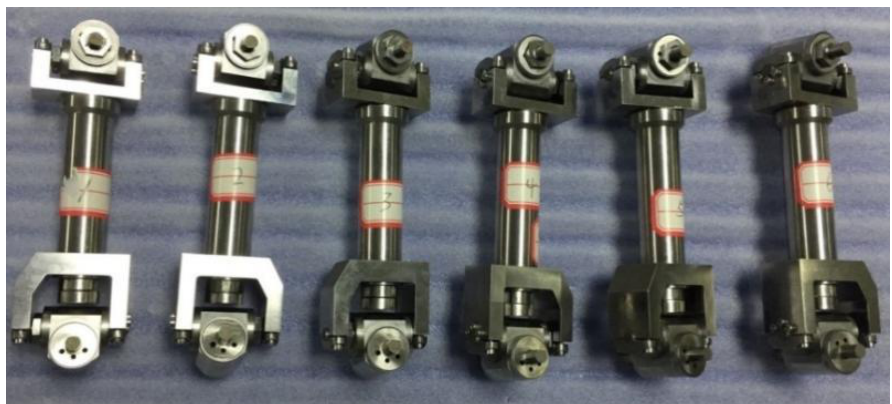
Figure 12. Prototype of RR-R-RR serial subchains.